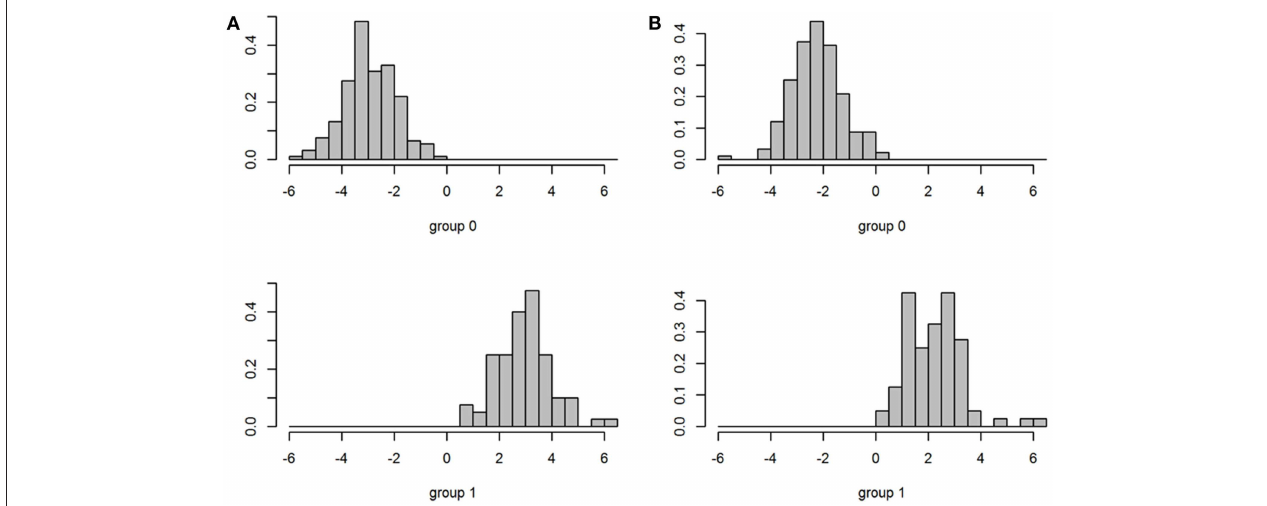
FIGURE 6 | Plots of discrimination between subspecies (Group 0 = rossicus and Group 1 = fabalis ) for models based on all 17 variables (A) and only two variables (B) .